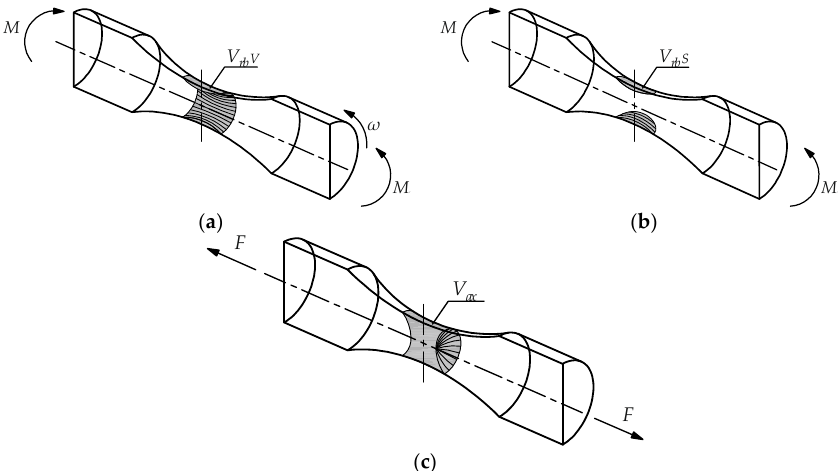
Figure 3. Boundary conditions for round specimen under: ( a ) rotary bending (highly-stressed volume), ( b ) pure bending (highly-stressed volume static), ( c ) axial loading.